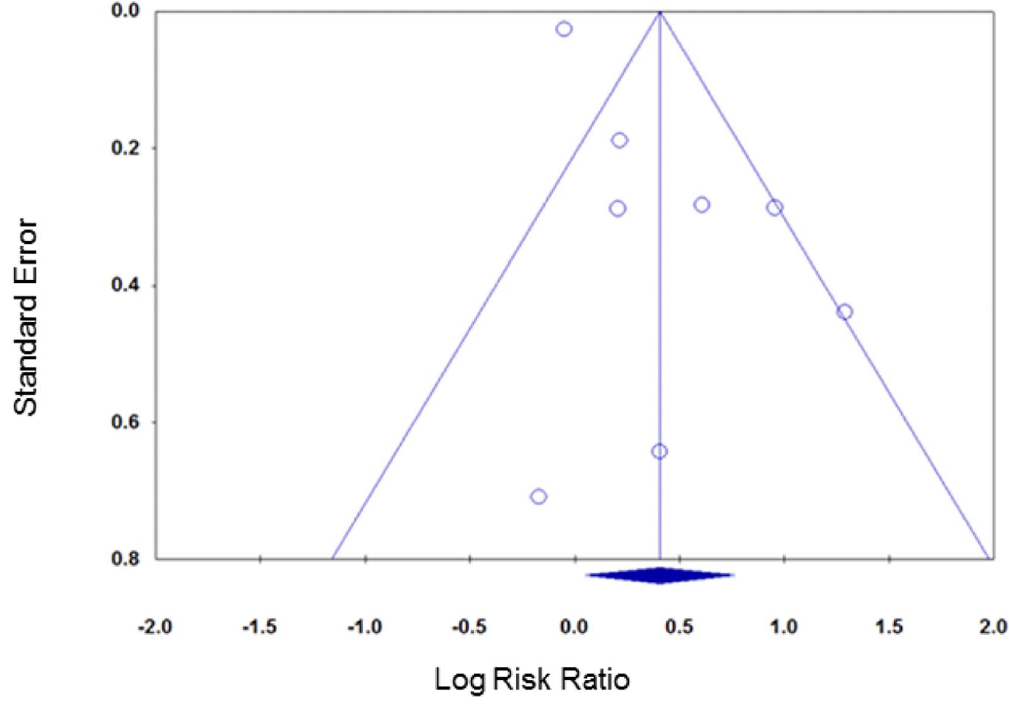
Figure 10. Contour enhanced funnel plot, smoking cessation (follow-up . six months).